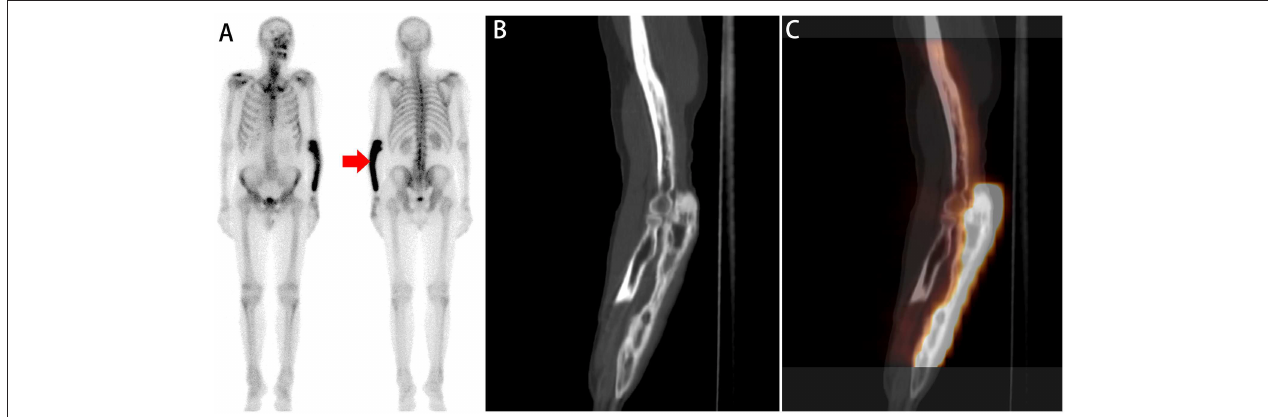
FIGURE 4 | A whole-body scan (A) revealed diffuse high 99m Tc-MDP activity in the left forearm (red arrow). No additional areas of abnormal 99m Tc-MDP uptake were identified in the remainder of the skeleton. Sagittal (B,C) CT and SPECT/ CT imaging showed diffusely increased 99m Tc-MDP uptake corresponding to irregular cortical thickening and porous sclerosis in the ulna. The diagnosis of Paget’s disease of bone was established by a combined assessment of clinical and radiologic follow-up.